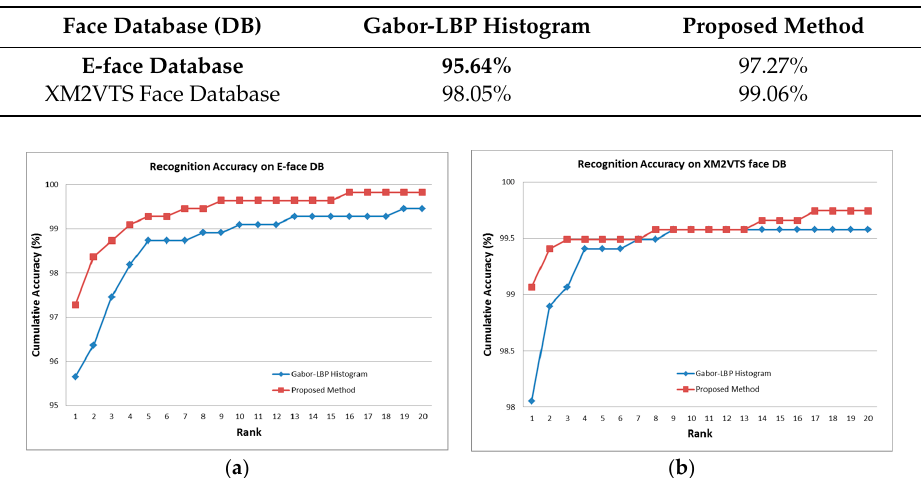
Table 1. Recognition rate (%) of the proposed face recognition approach compared with the Gabor-LBP histogram-based approach on the E-face and XM2VTS face databases. database containing sixteen different illuminations using the following criteria: TAR—true